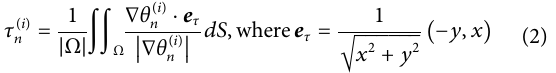
Figure 3B. By breaking the symmetry of the UC along different